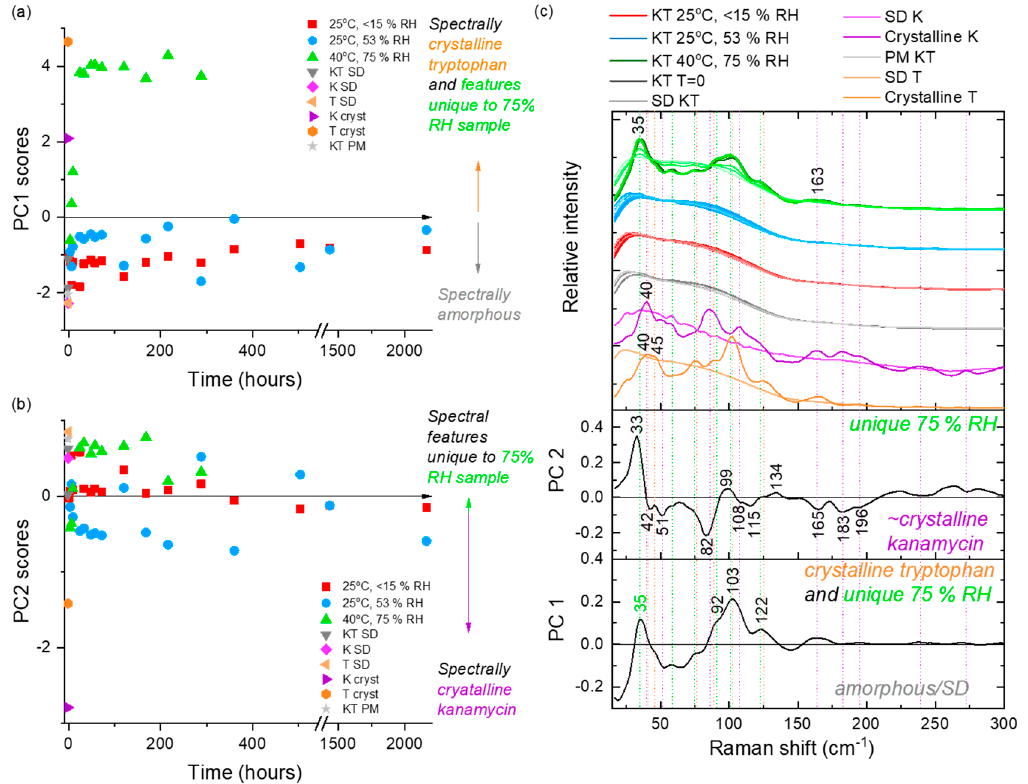
Figure 7. PCA analysis of the LFR spectra collected from KT samples stored under three different conditions (25 °C/<15% RH, 25 °C/53% RH and 40 °C/75% RH) over time. ( a ) PC1 scores versus time, ( b ) PC2 scores versus time, and ( c ) the associated loadings with comparative spectra. PM represents a physical mixture of amorphous kanamycin and amorphous tryptophan in a 1:1 molar ratio. PC 1 accounts for 83% of the explained spectral variance and PC 2 accounts for a further 7% explained variance. Spectra from the different storage conditions in ( c ) have slight color graduations to highlight early (lighter coloring) versus latter (darker coloring) time points.